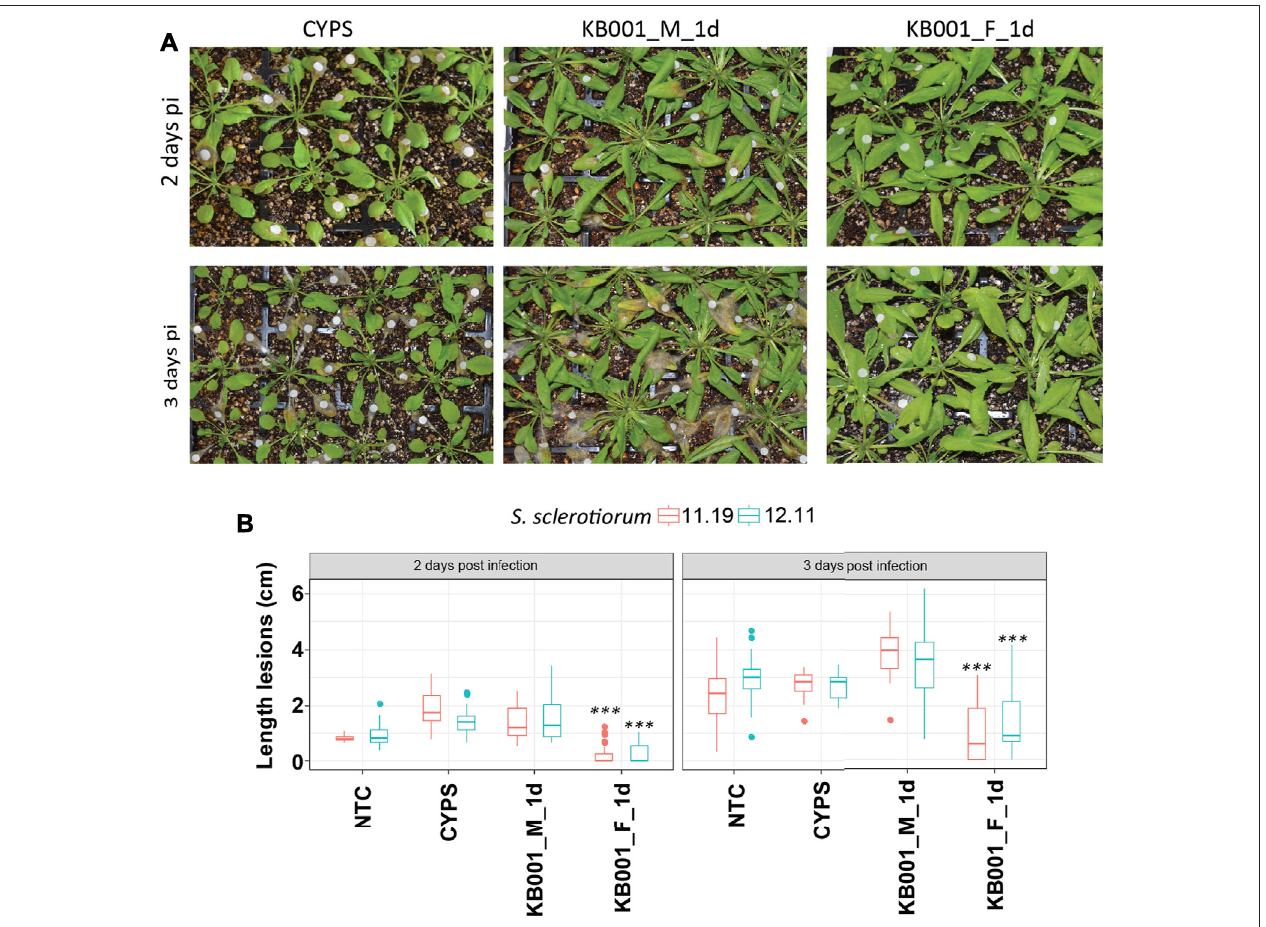
FIGURE 5 | Actinobacteria fi ltrate improves plant fi tness against Sclerotinia infection. Four-week-old Arabidopsis plants were treated with either KB001 microbe culture (KB001_M) or the KB001 fi ltrate (KB001_F) 1 day (1 day) prior to infection with Sclerotinia . A nontreated control (NTC) and CYPS treatment were used as references. Severity of symptoms was determined 2 and 3 days post-infection. (A) Plants were inoculated with Sclerotinia sclerotiorum isolate SS 12.11. White round Whatman paper discs show the location of inoculation. (B) Length of developed necrotic lesions infected with S. sclerotiorum strains SS 12.11 or 11.19 was measuredusingImageJsoftware.Representativephotographsareshownin5Aand SupplementaryFigureS3 andwereusedfortheanalysis.Shownistheaverageof 20 plants per treatment. Plants were infected with two strains of Sclerotinia (SS 12.11 and 11.19). A t -test was used to determine signi fi cant differences to CYPS samples. *** p <